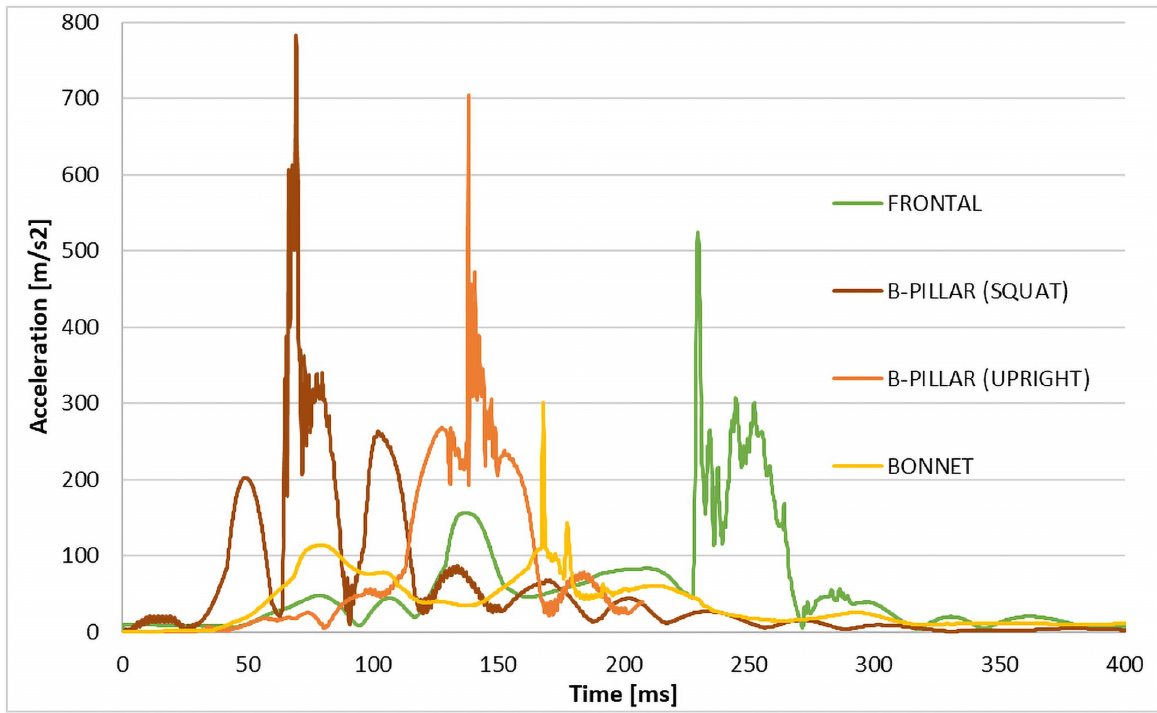
Fig 9. The plot of the head linear acceleration and its magnitude for the analyzed